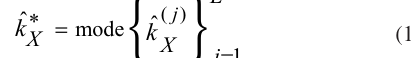
Table 5. Success rate over n = 200 runs.